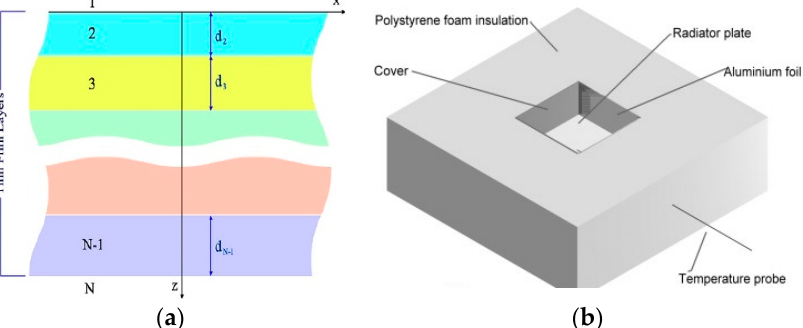
Figure 28. ( a ) An arrangement of thin-film multi-layer structure [154] and ( b ) radiative surfaces protected by cover shields [155].